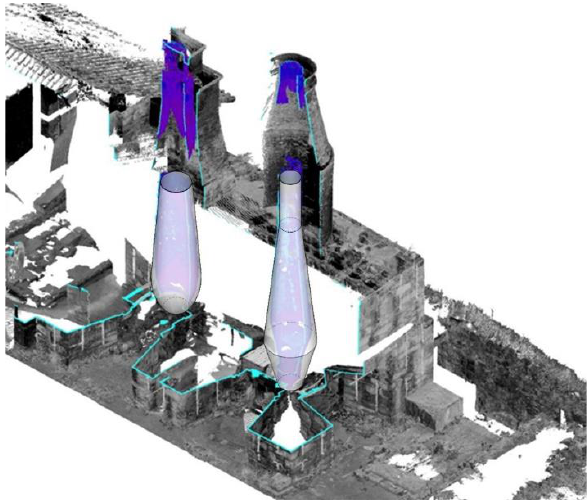
Figure 7: modelling phase of the two inner surface of the blast furnaces starting from the data collected by the digital campaign and later elaborated with alignment and cleaning